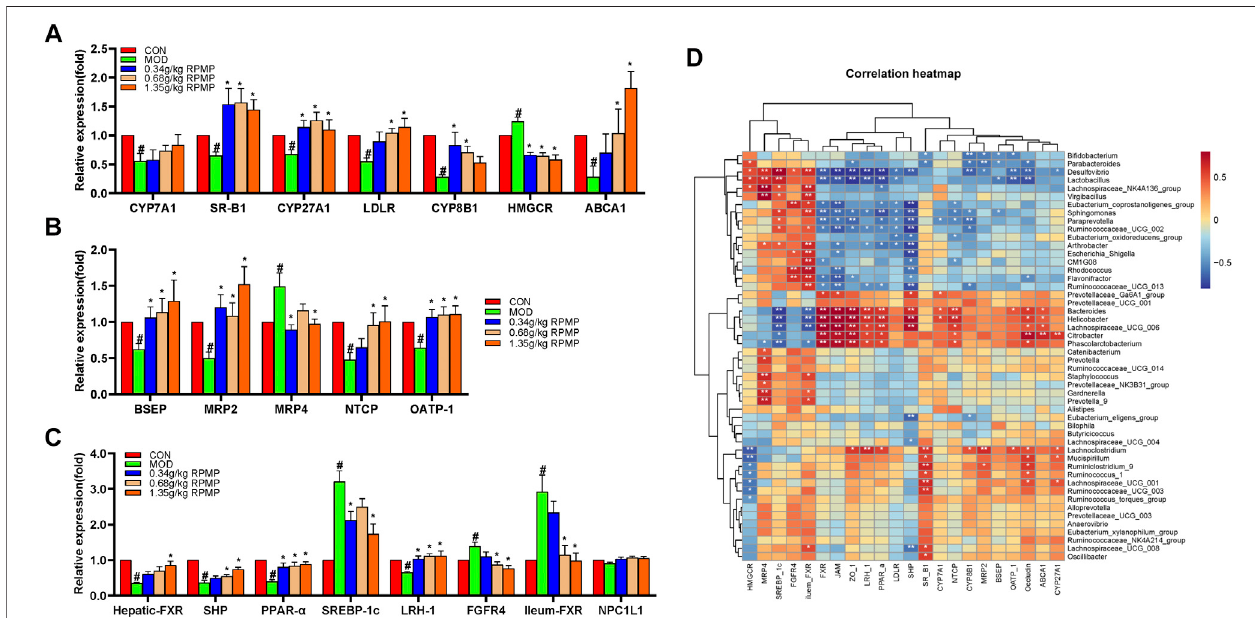
FIGURE12| EffectofRPMPethanolextractongenesrelatedtoBAsmetabolism. (A) GenesrelatedtoBAssynthesis. (B) GenesrelatedtoBAstransport. (C) BAs- regulatedrelatedgenes. (D) CorrelationanalysisofIMspecieswithBAsmetabolismandintestinalbarrier-relatedgenesinmice.Thedatawerepresentedasthemeans ± SEM, # p < 0.05, compared with the CON group; * p < 0.05, compared with the MOD group ( n (cid:2)